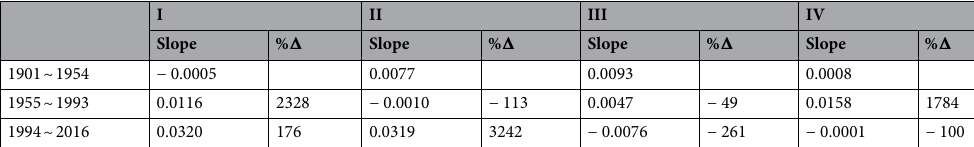
Table 1. Average trend slopes. A broken linear trend d it T 1 1954 and T 2 1993 is fitted for each temperature series. The average of those trends are computed for = = each quadrant in Fig. 1a, labelled I, II, III, and IV. The slope for 1901–1954 is a i 0 , a i 0 a i 0 a i 1 a i 2 for 1994–2016. The values of the slope are reported in columns labelled “slope”. The percent + + changes in the slope are reported in columns labelled “ % (cid:31) ”.